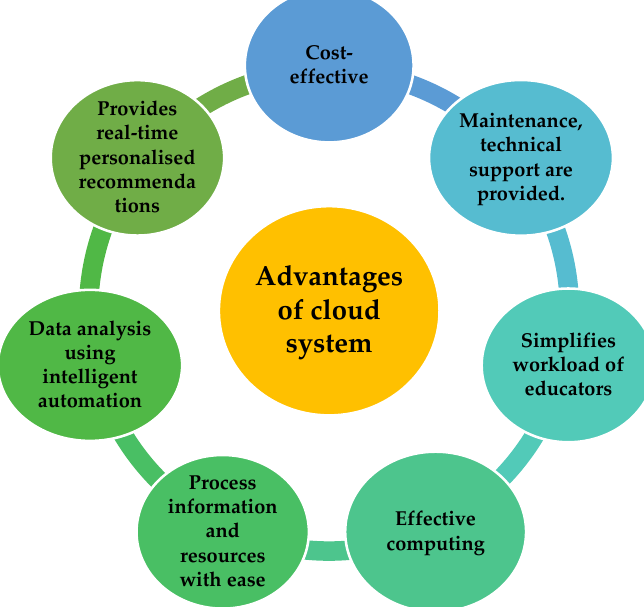
Figure 11. Benefits of using the cloud system in schools for personalised education.